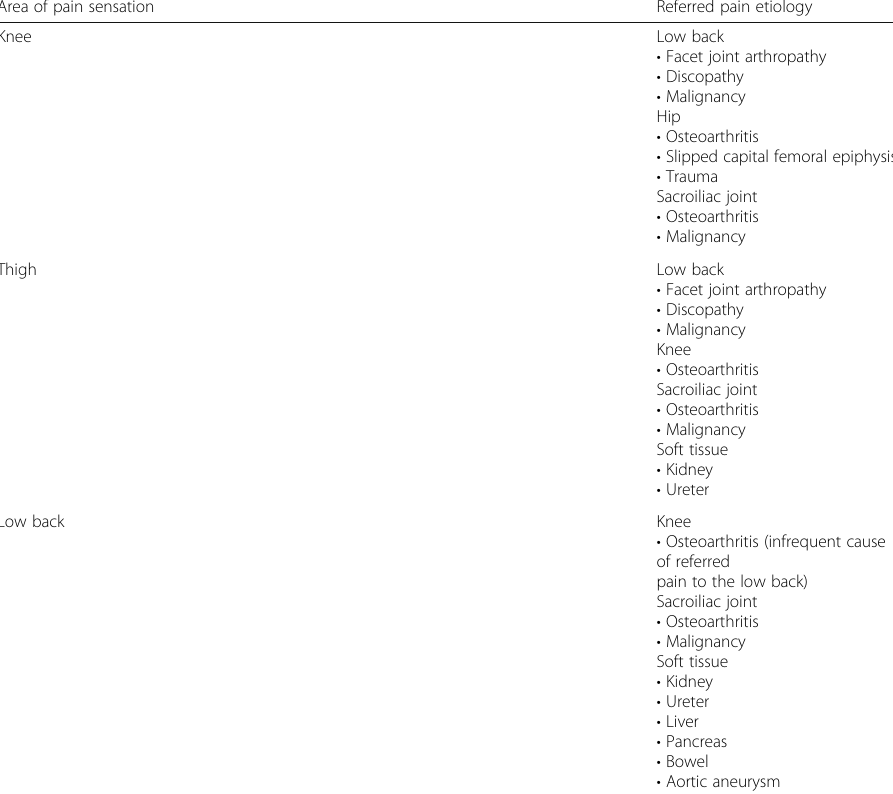
Table 2 Summary of causes of referred